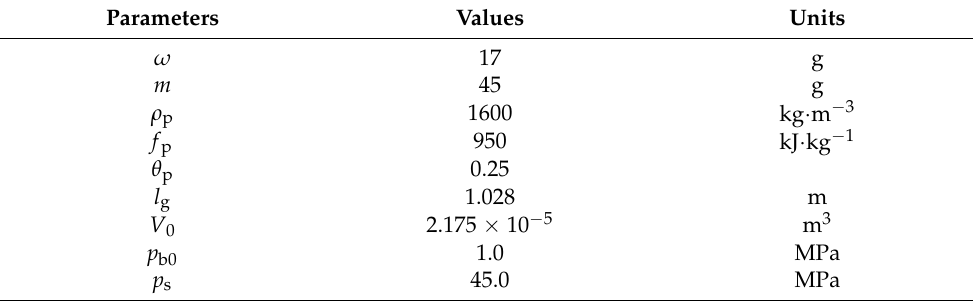
Table 3. Charging parameters.